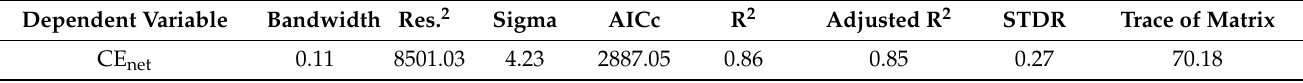
Table 4. The results of the